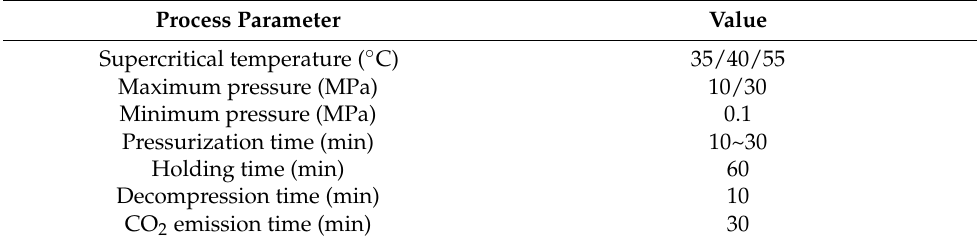
Table 1. Parameters of supercritical CO 2 dewatering